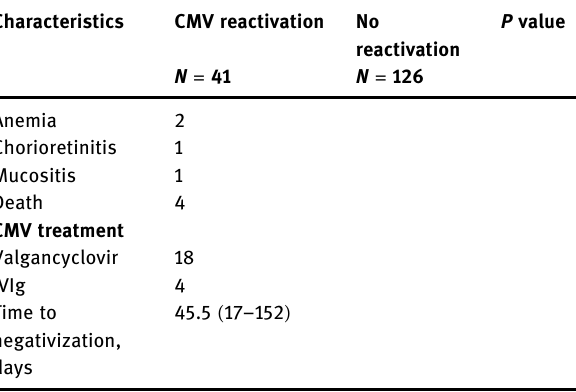
Table 2: Patients ’ characteristics at CMV reactivation